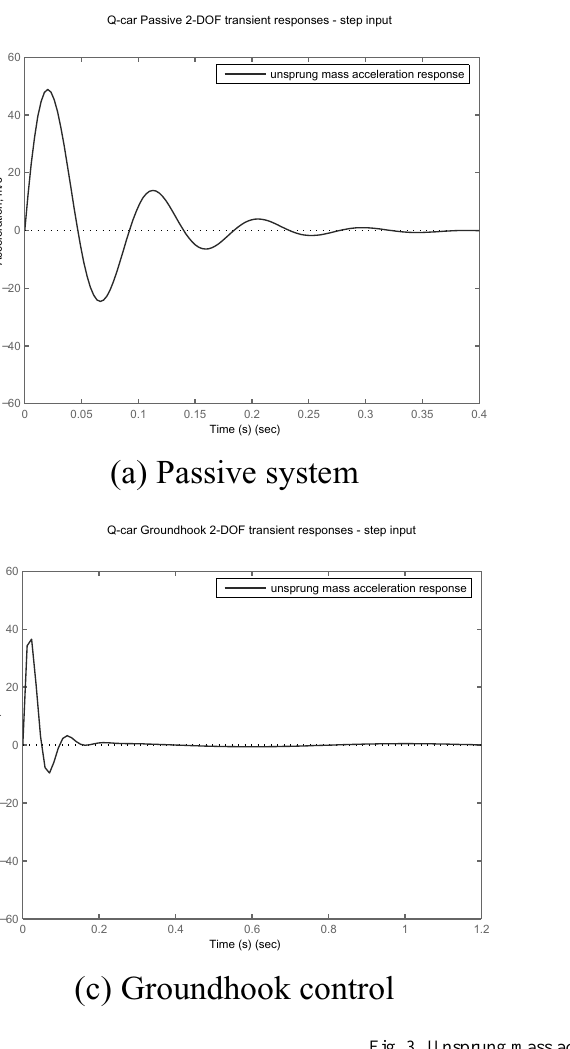
Fig. 3. Unsprung mass acceleration